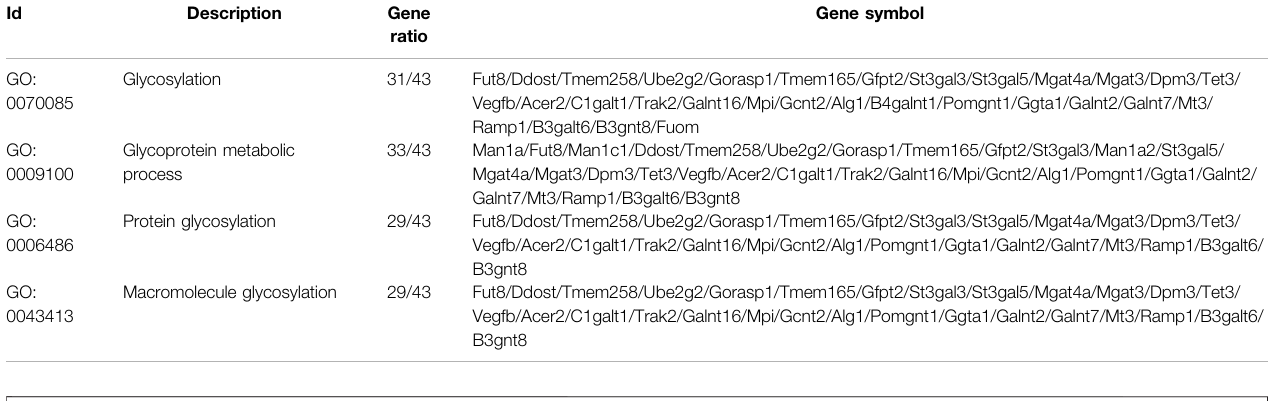
TABLE 2 | Gene regulation network was plotted based on the number of enriched genes in GO term.